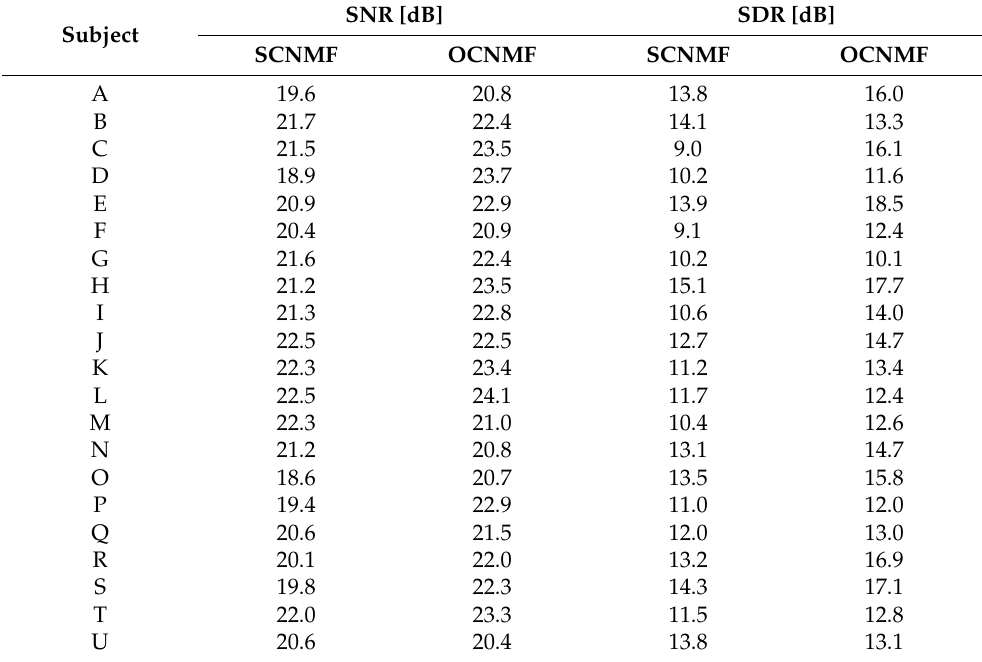
Table A2. SNR and SDR for each subject in the case of male voice